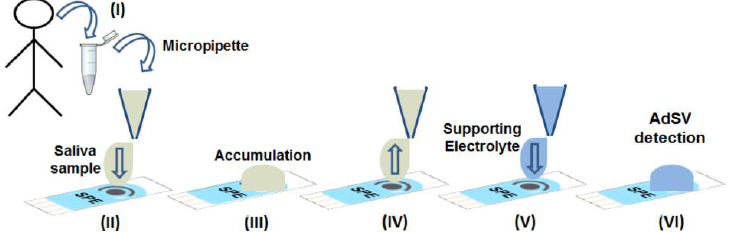
Figure 7. Analysis of authentic saliva samples by the adsorptive stripping wave voltammetry tech- nique using SPE-CNT. Saliva samples were collected (I) using Salivetts ® , see Section 2.3 (Please, refer to the original work at [122]). (II) the saliva samples (100 μL) with or without addition of modafinil were drop-casted on SPE-CNT using a micropipette; (III) the accumulation step required for AdSV